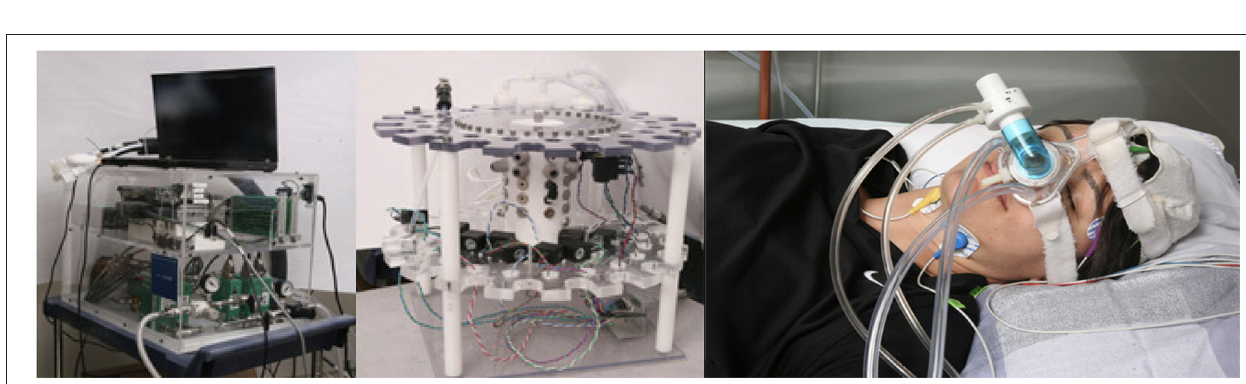
FIGURE 2 | The images depict a typical sleep study using olfactory stimulation. The experiment is conducted in a laboratory with a nasal mask attached to an olfactometer that releases various scents stored in the bottles. Images by (Arzi et al., 2014)